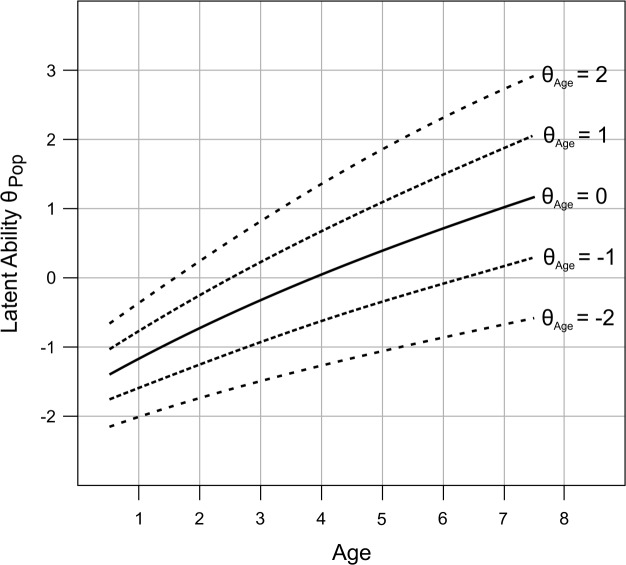
Age progression of the fictitious ability in the simulated population.θAge corresponds to the latent ability z-standardized with regard to subjects of exactly the same age and θPop corresponds to the latent ability z-standardized with regard to the total population.